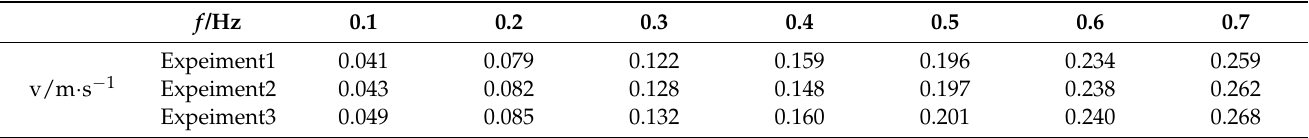
Table 3. Performance repeatability test of bionic pump